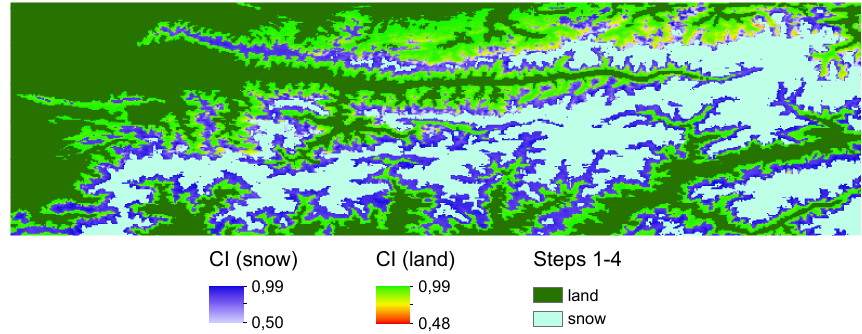
Figure 9. Fraction of reconstruction in steps 1–4 and maximum CI values for snow and land in step 5 for the study area illustrated in Fig. 1b.